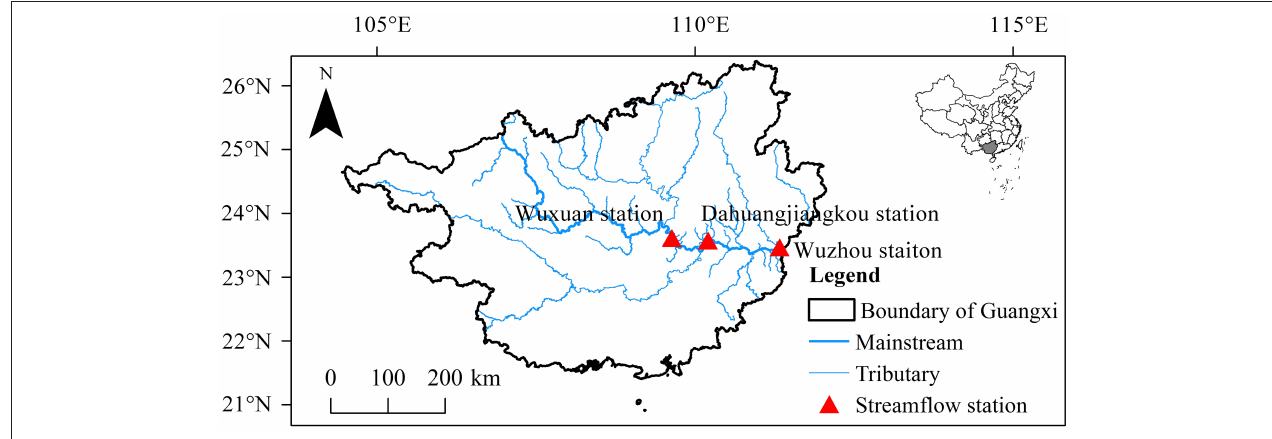
FIGURE 1 | Map of the study